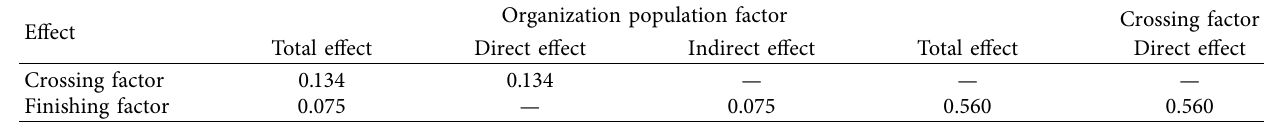
Table 1: Variables in the offensive tactics of free kicks and corner kicks.